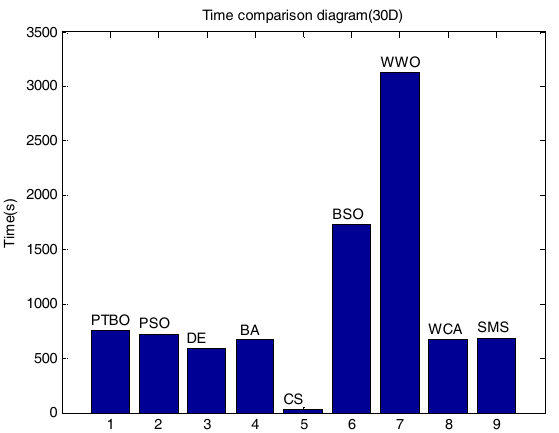
Figure 10. The mean central processing unit (CPU) time of the nine compared algorithms. 30D: 30 dimensions.